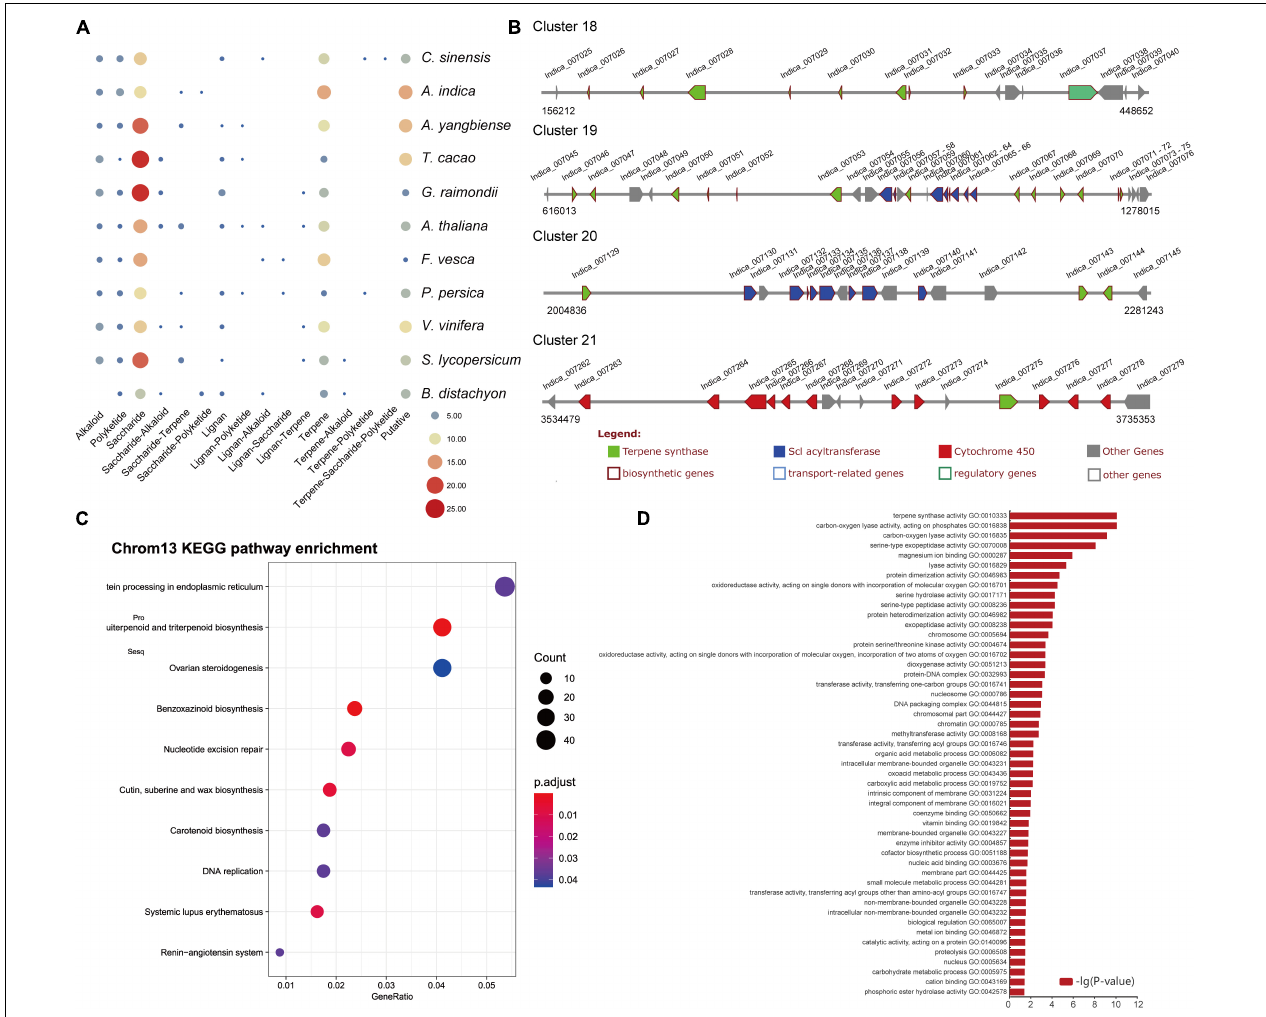
FIGURE 4 | Secondary metabolite analysis. (A) Secondary metabolite analysis of A. indica and other 11 species. (B) The organization and architecture of terpene-related gene clusters on chromosome 13. (C) Dot plot of the KEGG pathway enrichment analysis of genes on chromosome 13. (D) The GO enrichment analysis of genes on chromosome 13 ( P <